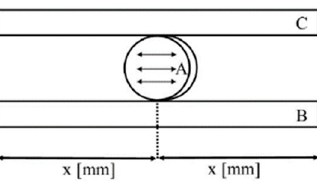
Figure 3. Diametral compressive strength test diagram. Sample ( A ) is placed in the central part of the lower compression anvil ( B ) positioned in parallel to the upper compression anvil ( C ).